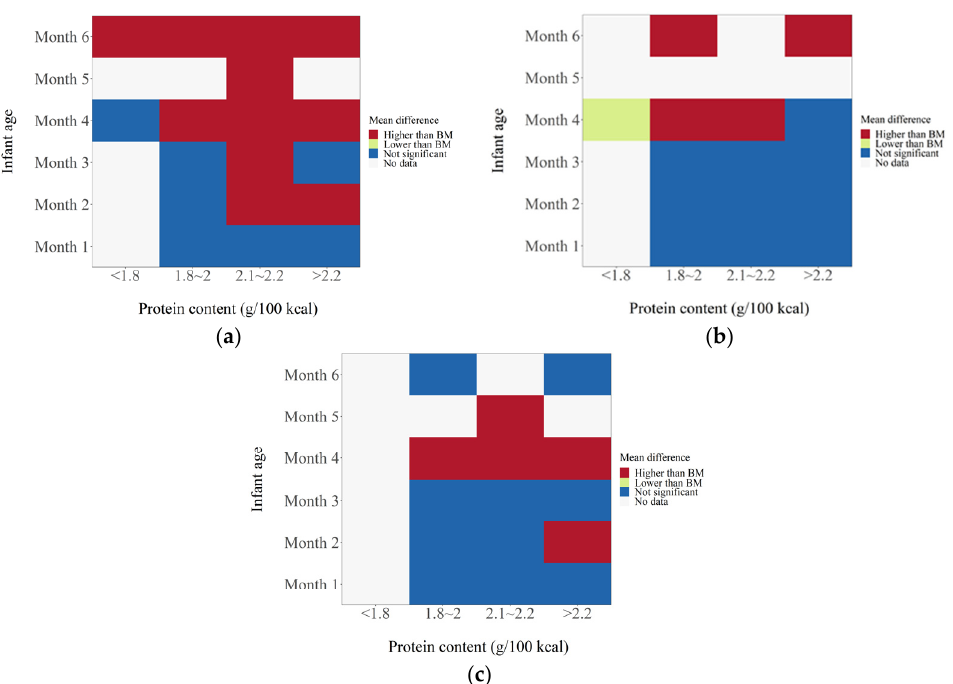
Figure 7. Heat map of the effects of protein content of infant formulas on the growth of infants. ( a ) The effects on weight gain. ( b ) The effects on height gain. ( c ) The effects on BMI.